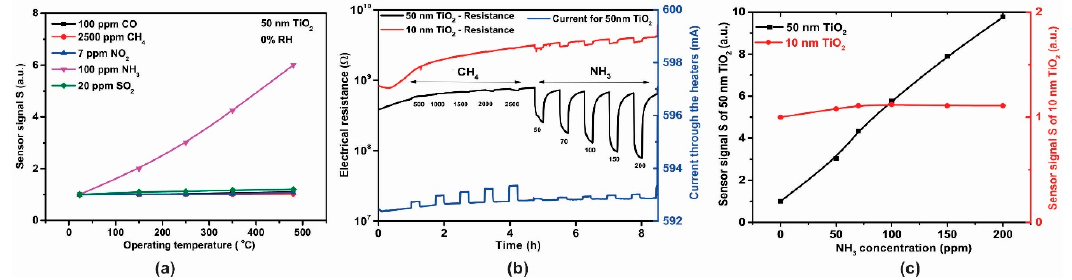
Figure 13. ( a ) Temperature dependence of sensitivity for 50 nm TiO 2 sensor after exposure to CO, CH 4 , NO 2 , NH 3 , SO 2 , ( b ) Electrical resistance and current response of TiO 2 gas sensors exposed to different concentrations of CH 4 and NH 3 under 0% RH at 480 °C and ( c ) Sensor signal for 10 nm and 50 nm thickness TiO 2 sensors.